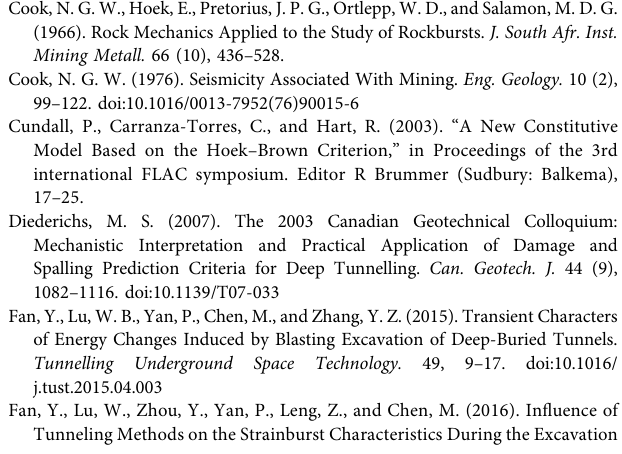
Figure 11 . From this point of view, the prediction method of rockbursts proposed in Figure 11 is better than that in Eq. 20